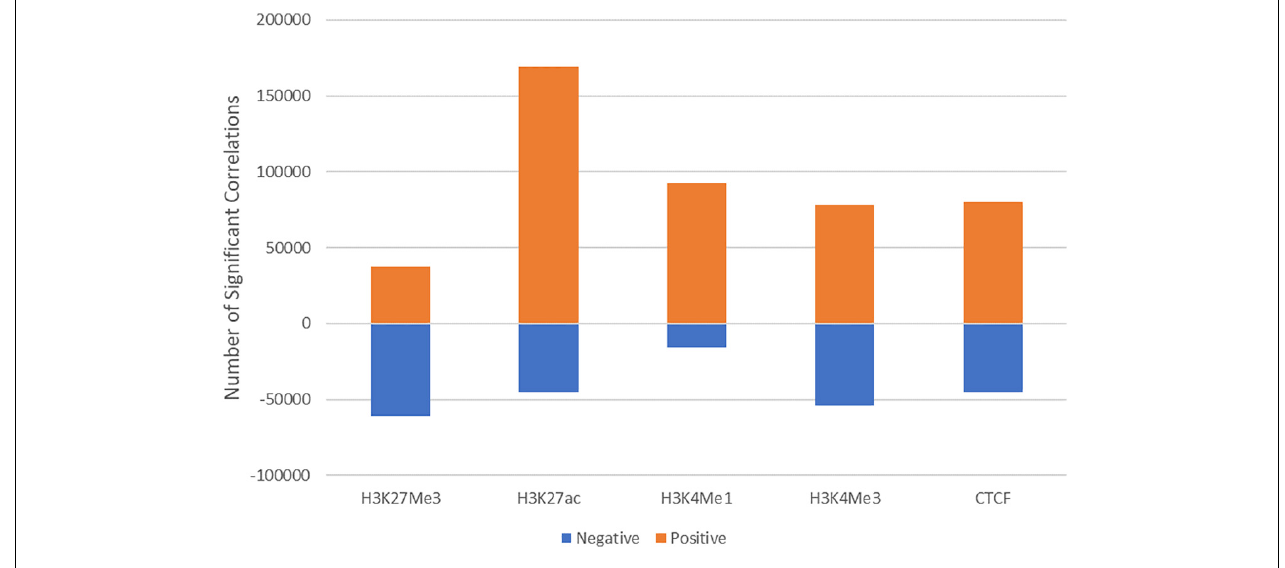
FIGURE 3 | Direction of significant correlations. The direction of correlations between ChIP-seq and RNA-seq counts for H3K27Me3, H3K27ac, H3K4Me1, H3K4Me3, and CTCF.